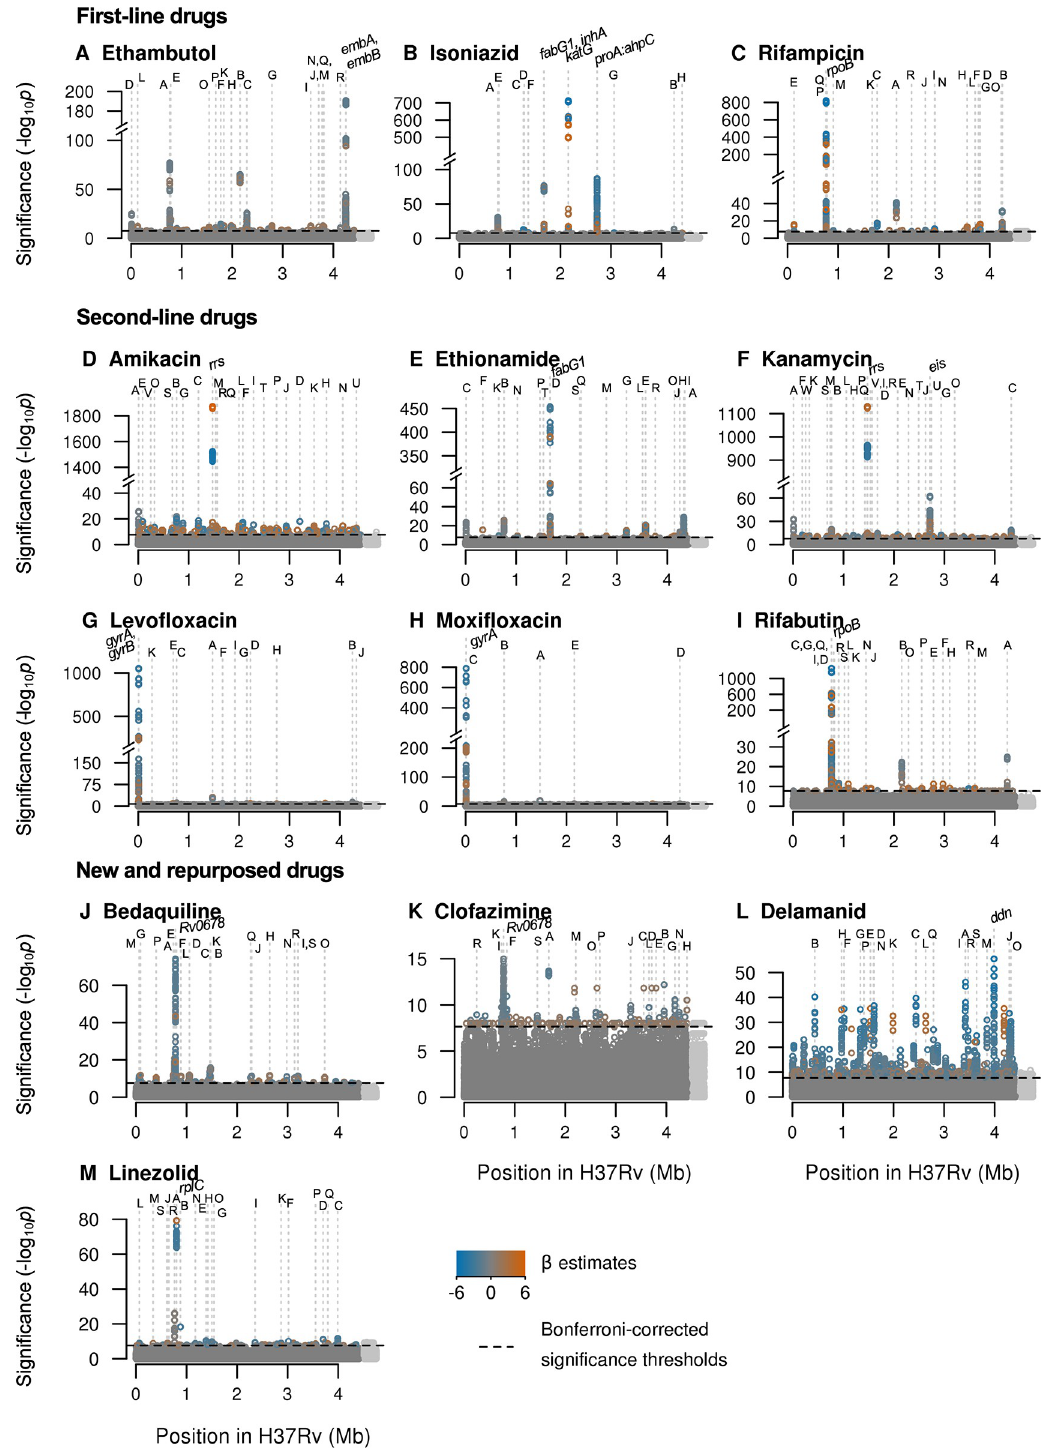
Fig 3. Manhattan plots of regions containing oligopeptide variants associated with MIC across 13 drugs. Significant oligopeptides are coloured by the direction (orange = increase, blue = decrease) and magnitude of their effect size on MIC, estimated by LMM [32]. Bonferroni-corrected significance thresholds are shown by the black dashed lines. The top 20 genes ranked by their most significant oligopeptides are annotated alphabetically. Gene names separated by colons indicate intergenic regions. Gene names for those annotated with letters can be found in Table 1. Oligopeptides were aligned to the H37Rv